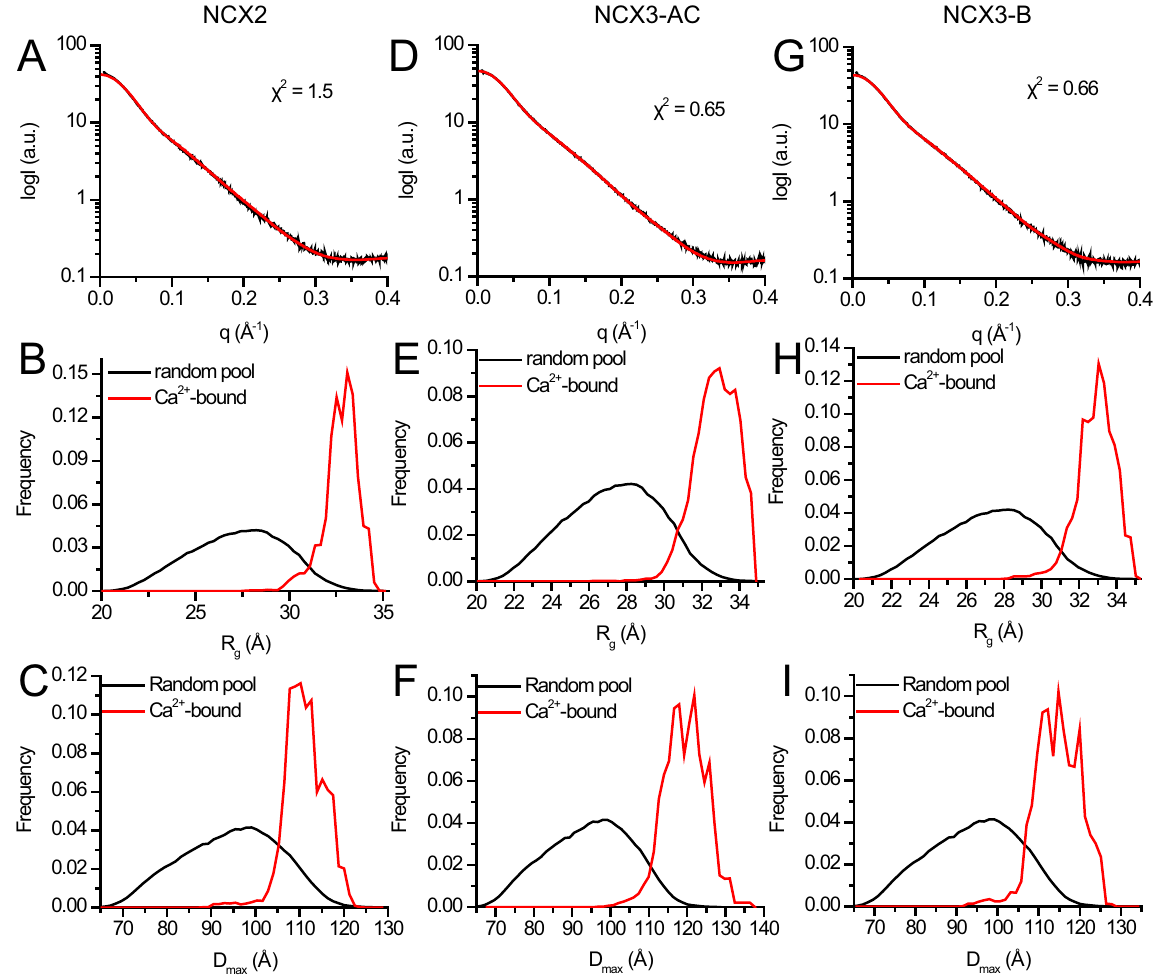
Figure 3. EOM analyses of CBD12 from NCX2 and NCX3. ( A , D , G ) Experimental SAXS curve and EOM fit of CBD12 from NCX2 ( A ), NCX3-AC ( D ), and NCX3-B ( G ) in the presence of Ca 2 + . ( B , E , H ) Random R g pool (black line) and EOM-selected ensemble (red line) distributions of NCX2-CBD12 (B), NCX3-CBD12-AC ( E ), and NCX3-CBD12-B ( H ). ( C , F , I ) Random D max pool (black line) and EOM-selected ensemble (red line) distributions of NCX2-CBD12 ( C ), NCX3-CBD12-AC ( F ), and NCX3-CBD12-B ( I